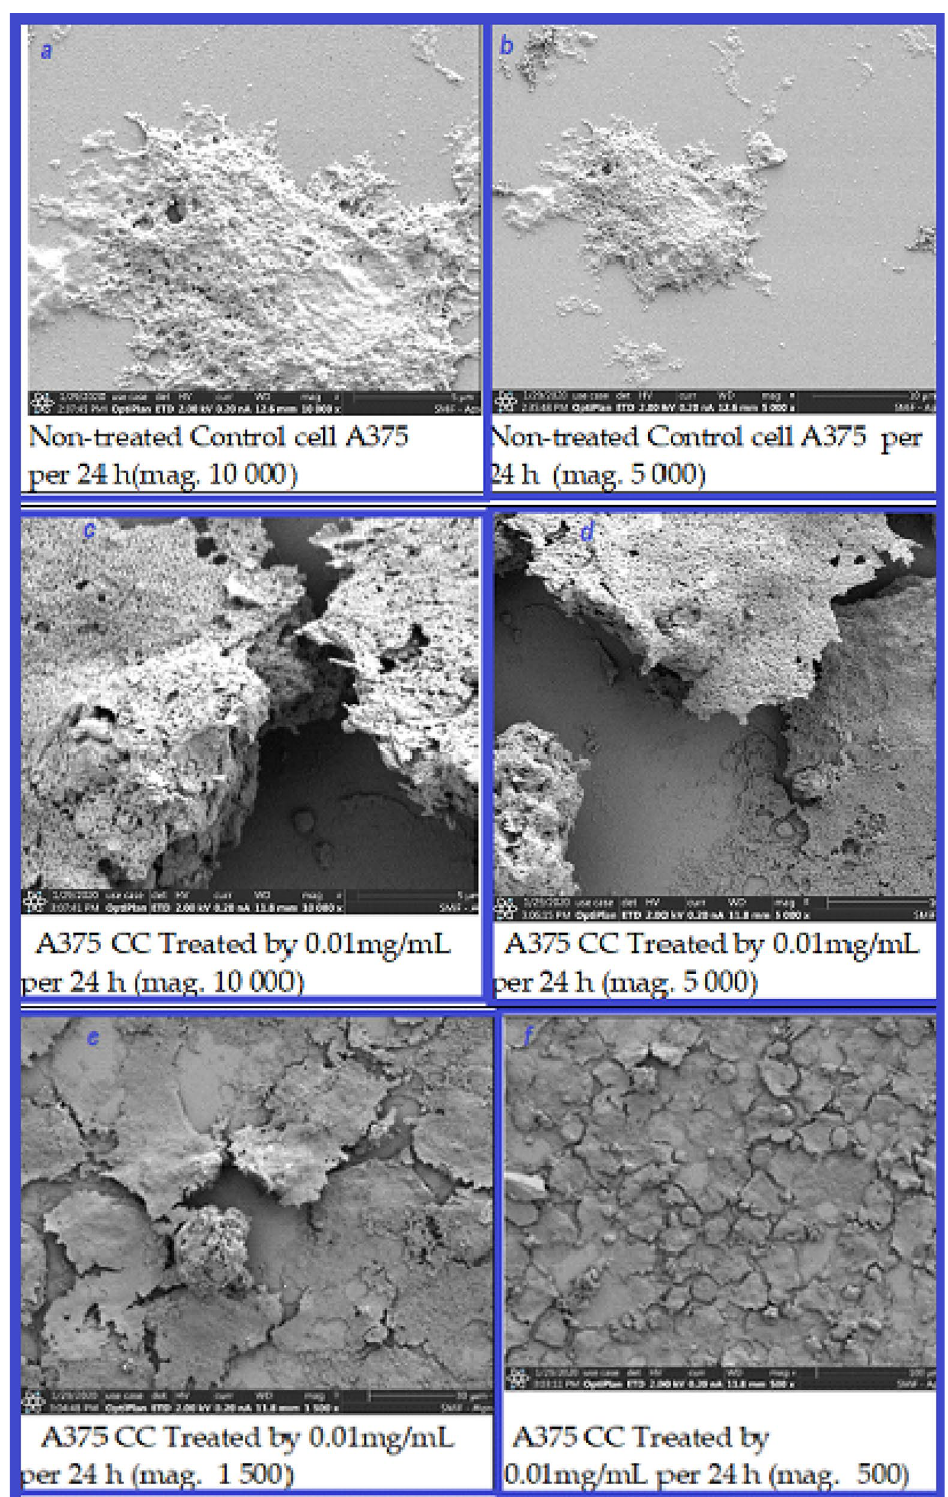
Figure 7. Representative SEM images of treated and non-treated A375 cancer cells. Untreated A375 cancer cells are represented in (a,b) at higher magnification—×10000 and ×5000, respectively. A375 cancer cells treated with 0.01 μg/mL of AgNPs@C_MA_O for 24 h are shown at (c,d) at higher magnification—10,000 and 5000; and 1500 and 500 magnification in (e,f) ,